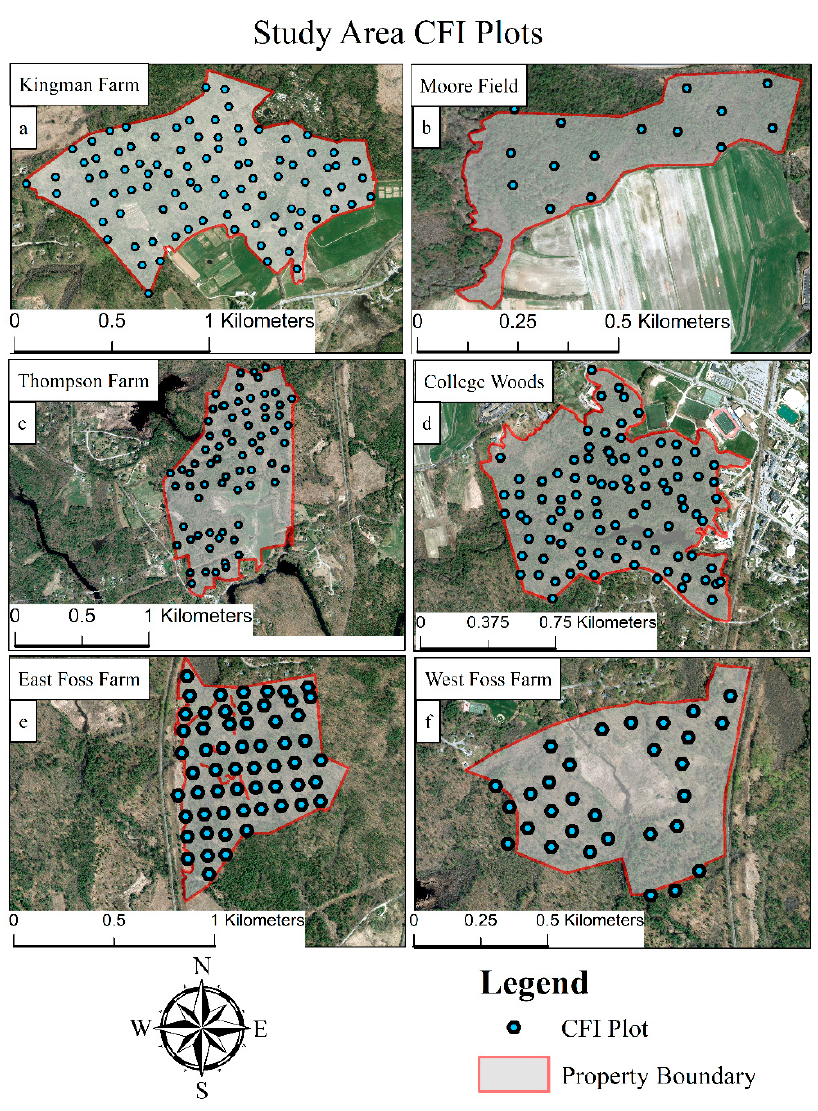
Figure 2. Woodland property continuous forest inventory (CFI) plot networks totaling 354 horizontal point sampling plots over 377.57 ha of forested land. Pictured are (Top left to bottom right): ( a ) Kingman Farm, ( b ) Moore Field, ( c ) Thompson Farm, ( d ) College Woods, ( e ) East Foss Farm, and ( f ) West Foss Farm.